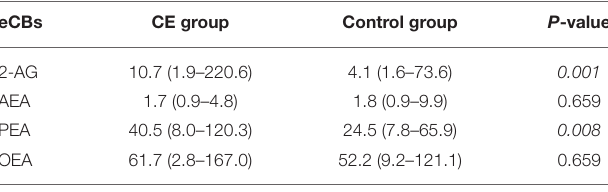
( Table 5 ). Among healthy dogs, no correlations between levels of circulating eCBs and bodyweight or age were observed ( Figure 1